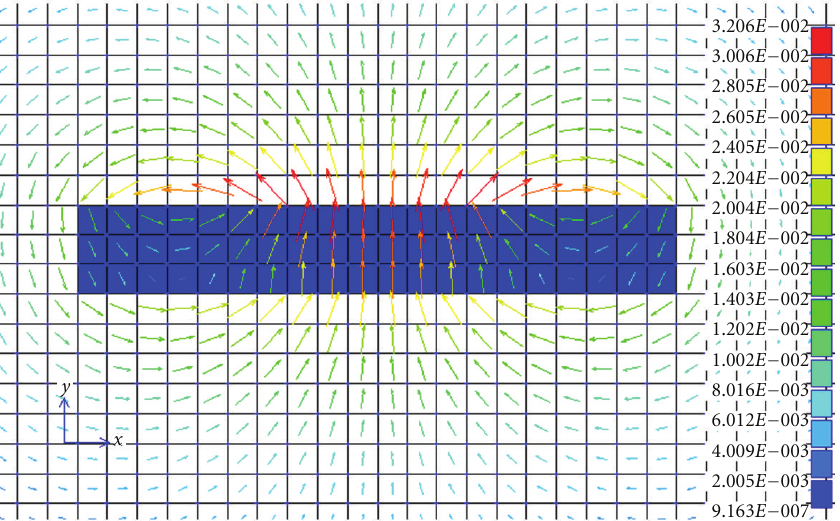
Figure 7: Analytical result of magnetic flux density vector after the magnetization in the same direction.